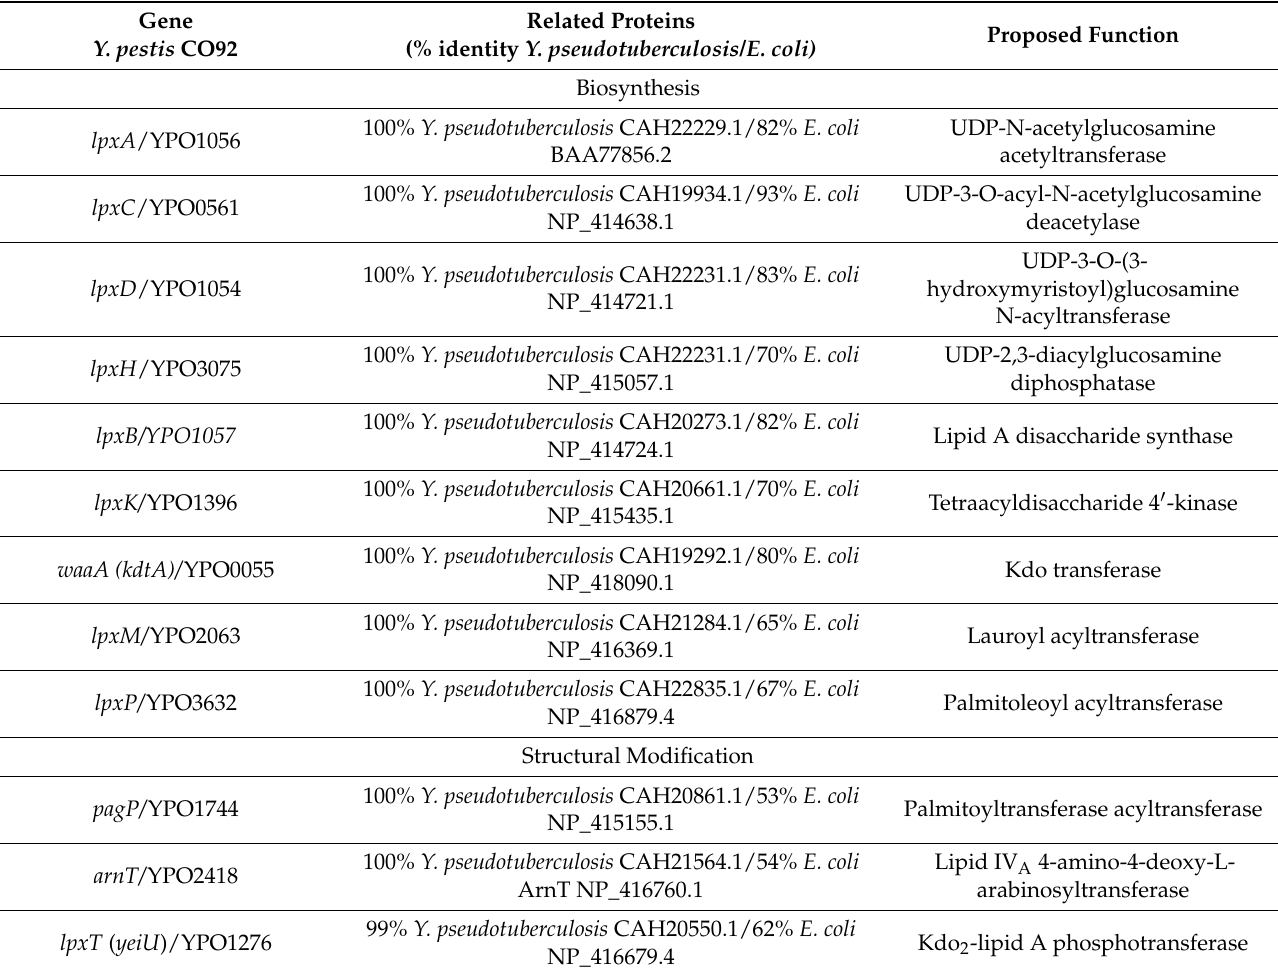
Table 3. Homologues of Y. pestis lipid A biosynthesis and structural modification genes found in the Y. pseudotuberculosis / E. coli genomes. Sequence conservation relates to alignments with the Y. pseudotuberculosis IP 32953 and E. coli K-12